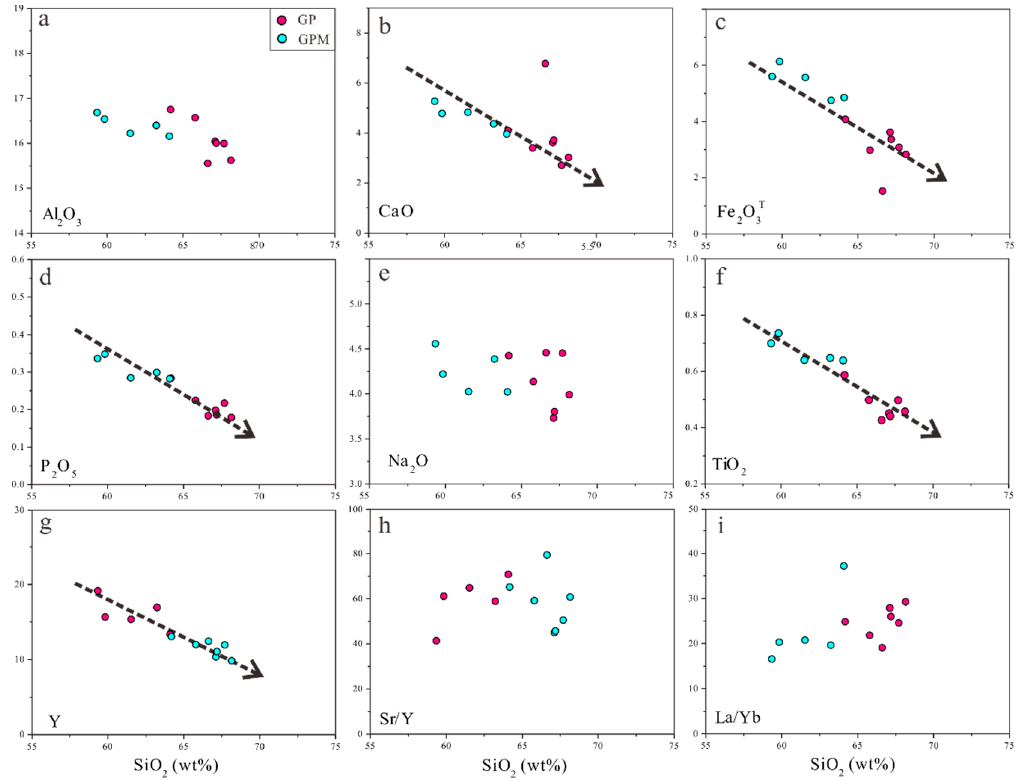
Figure 6. Harker diagram of the Qiaomaishan intrusions. Plot of ( a ) SiO 2 vs. Al 2 O 3 , ( b ) SiO 2 vs. CaO, ( c ) SiO 2 vs. Fe 2 O 3T , ( d ) SiO 2 vs. P 2 O 5 , ( e ) SiO 2 vs. Na 2 O, ( f ) SiO 2 vs. TiO 2 ( g ) SiO 2 vs. Y, ( h ) SiO 2 vs. Sr/Y, ( i ) SiO 2 vs. La/Yb for the Qiaomaishan intrusions.